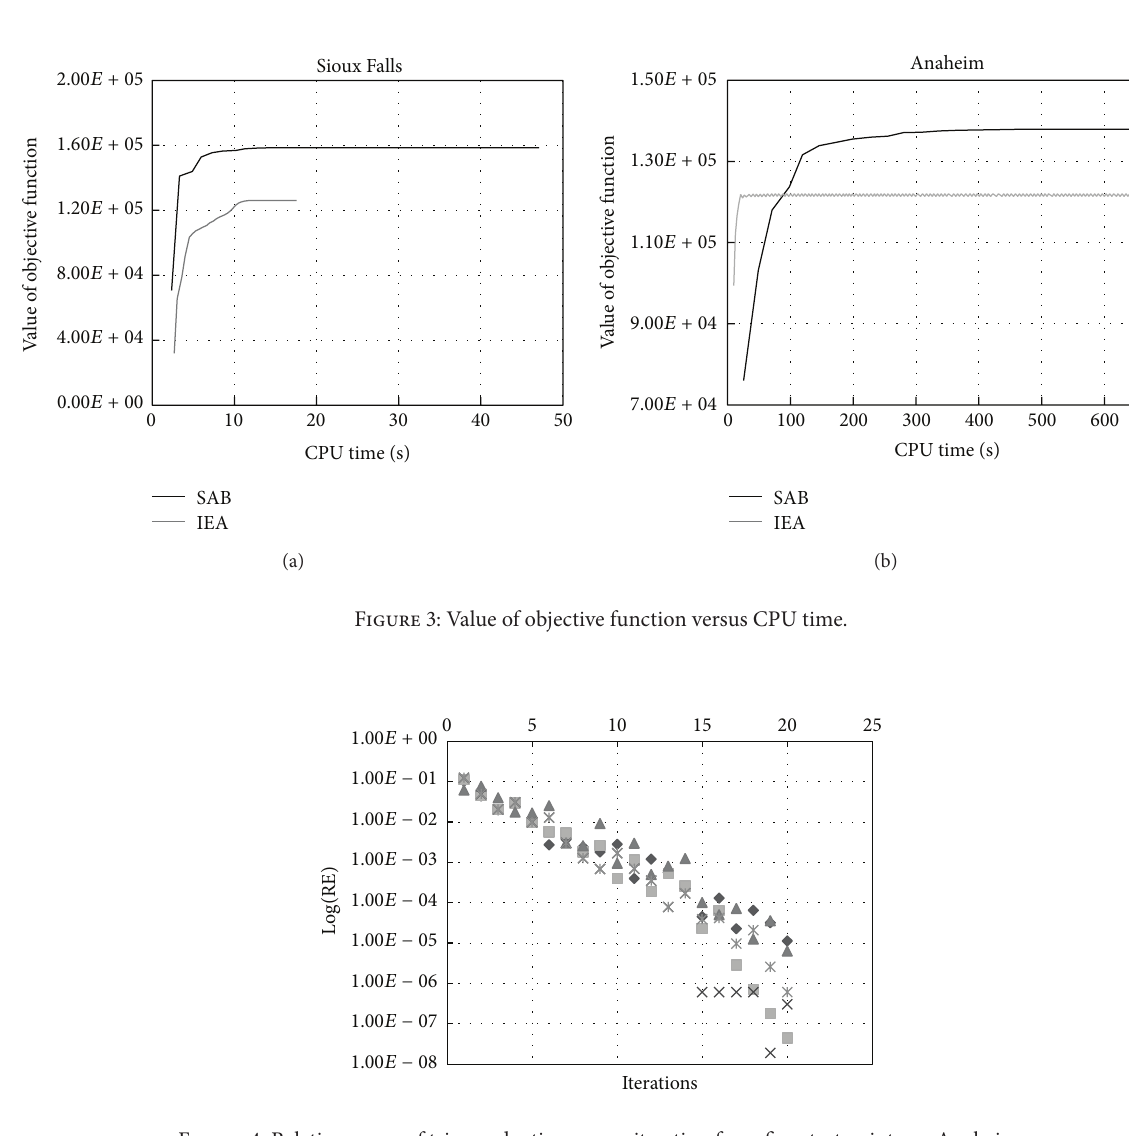
Figure 4: Relative errors of trip production versus iteration from five start points on Anaheim.